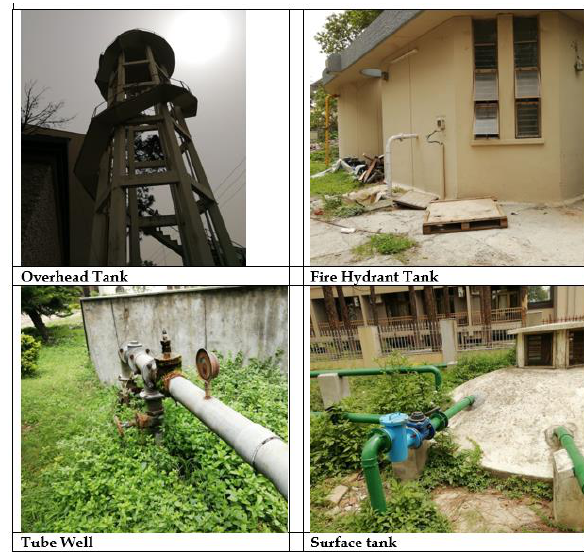
Figure 6 Field Data